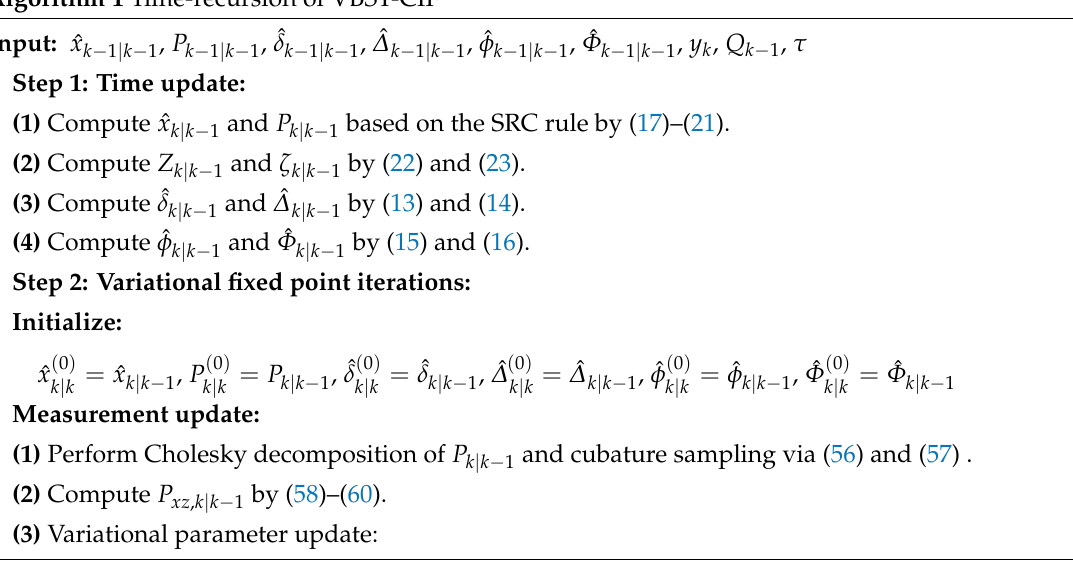
Algorithm 1 Time-recursion of